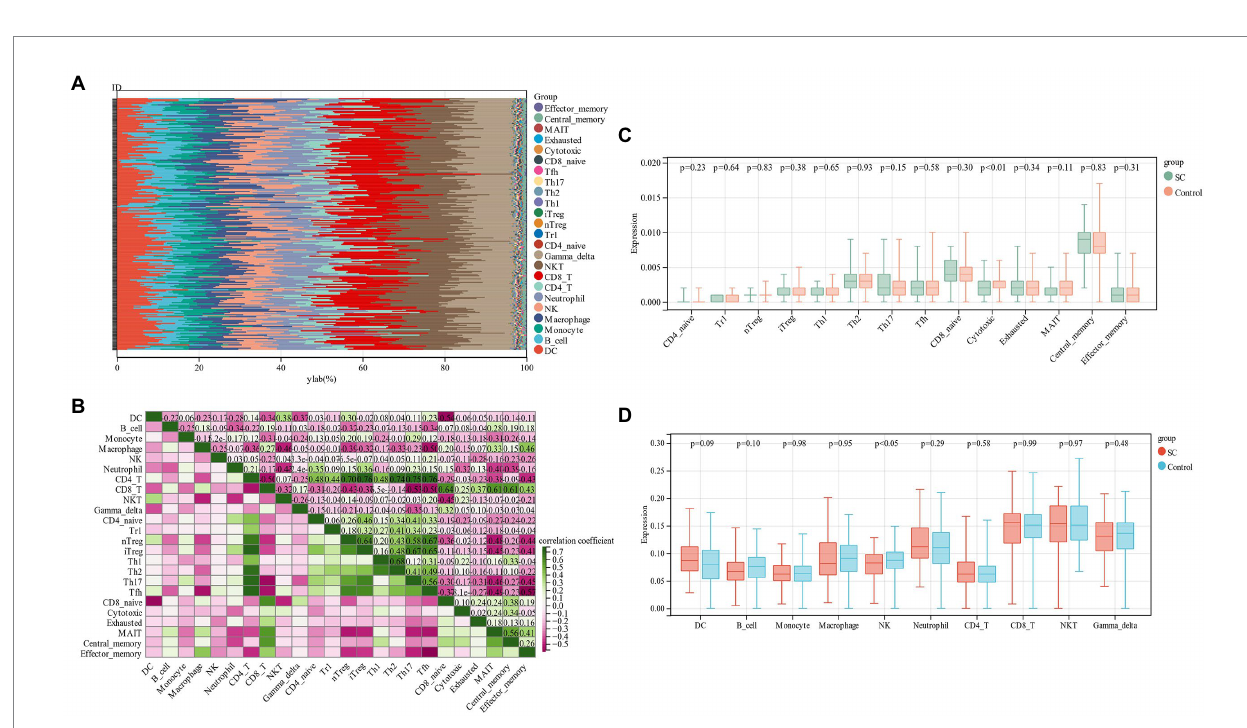
FIGURE 6 (A) Relative percentage of 24 immune cells per sample; (B) Correlation between 24 immune cells; (C,D) Differences in immune infiltration between schizophrenia samples and control